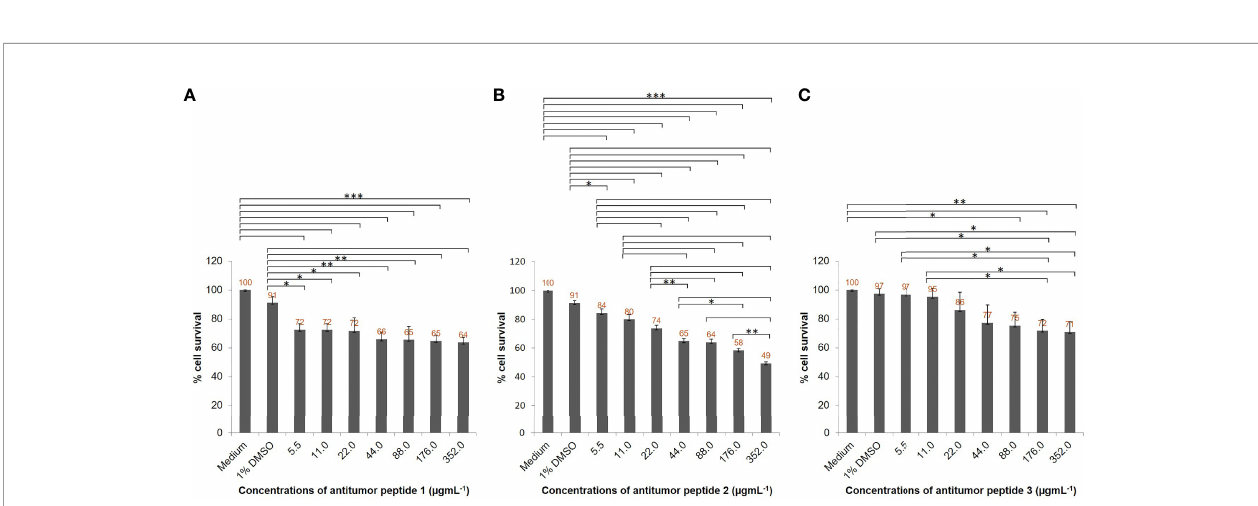
FIGURE 6 | Antihepatocellular carcinoma activity of the three peptide candidates. HepG2 cell lines (5 × 10 3 cells) in individual wells of a 96-well culture plate were treated with different concentrations (5.5, 11, 22, 44, 88, 176, and 352 µgmL -1 ) of individual antitumor peptides for 24 h. (A) Percentage cell survivals of HepG2 cells at 24 h posttreatment with different concentrations of antitumor peptide 1. (B) Percentage cell survivals of HepG2 cells at 24 h posttreatment with different concentrations of antitumor peptide 2. (C) Percentage cell survivals of HepG2 cells at 24 h posttreatment with different concentrations of antitumor peptide 3. Medium alone and medium supplemented with 1% DMSO were used as negative and diluent controls, respectively. The results are shown as the mean ± standard deviation (SD) of three independent experiments. ∗ P < 0.05; ∗∗ P < 0.01; ∗∗∗ P <